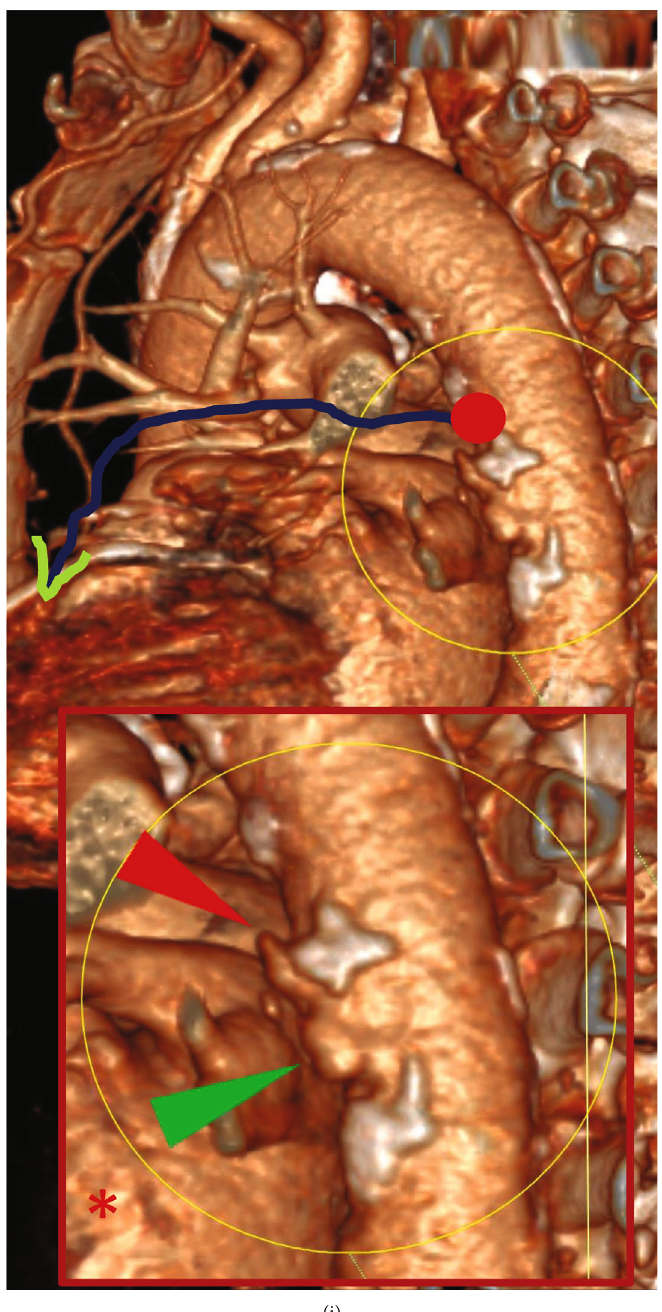
Figure 5: CTA showed a focal contrast- fi lled outpouching (PAU) of the proximal descending thoracic aorta (green arrowhead in (e, f, and h)), associated with a ULP originating from the entrance port of the PAU (yellow arrowheads in (b – d) and red arrowhead in g, h)). Obliterated paraesophageal fat ( ∗ in (a – d)) and aortic intramural hematoma are clearly visible (yellow arrowheads in (a)). Aortic 3D volume-rendering (i) and focal detail show a bifurcated aspect of PAU (green arrowhead) and ULP (red arrowhead)